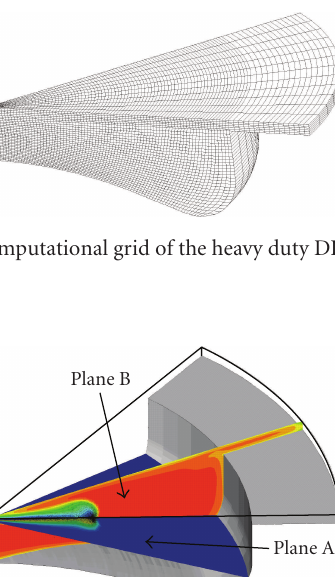
Figure 13: Computational grid of the heavy duty DI diesel engine. Table 3: Injection parameters for the base